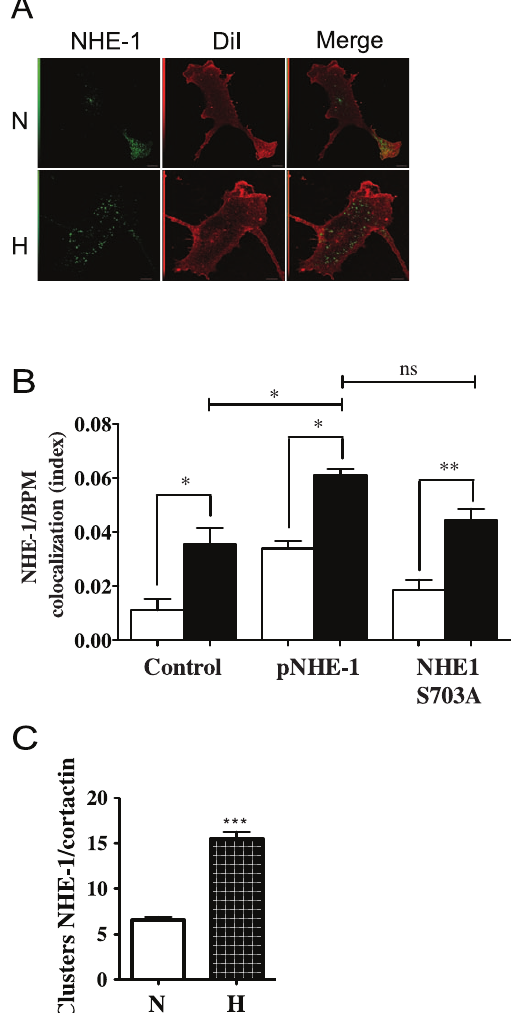
Figure 7. NHE-1 is localized at invadopodia sites. (A) Represen- tative confocal microscopy images showing NHE-1 staining at the basal membrane (labeled with DiI) in HT-1080 cells cultured under normoxic or hypoxic conditions. ( B ) Colocalization index of NHE-1 and basal plasma membrane (BPM) for untransfected cells or cells transfected with WT NHE-1 or a S703A substitution NHE-1 mutant exposed to normoxic (empty bars) or hypoxic (solid bars) conditions (n=3). (C) Numbers of cortactin/NHE-1 clusters per cell were quantified in HT-1080 cells cultured under normoxia or hypoxia for 4 h (n=3). N, normoxia; H, hypoxia. Columns represent the mean 6 SEM indicated by the horizontal bars. The asterisks correspond to, * p , 0.01; ** p , 0.001; *** p ,